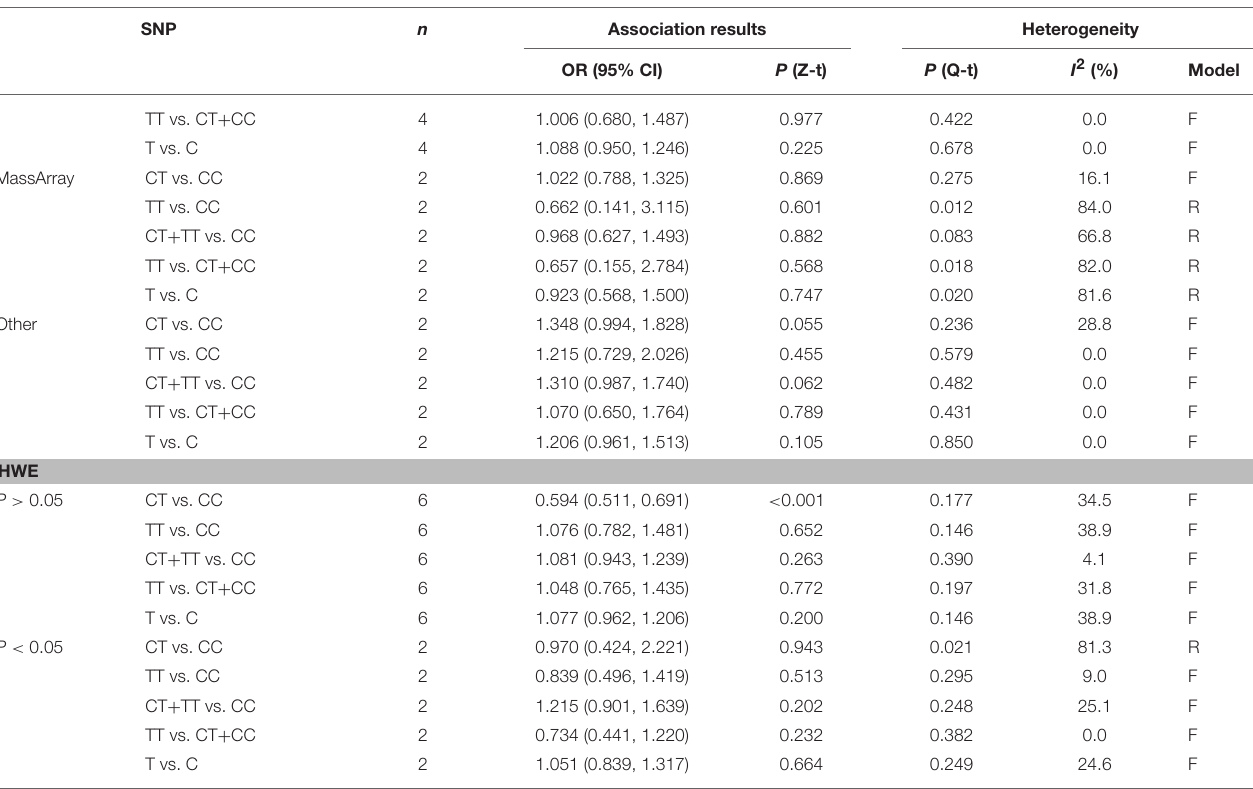
( Table S1 ). The results of stratified analyses for rs2274223 were basically consistent with results of